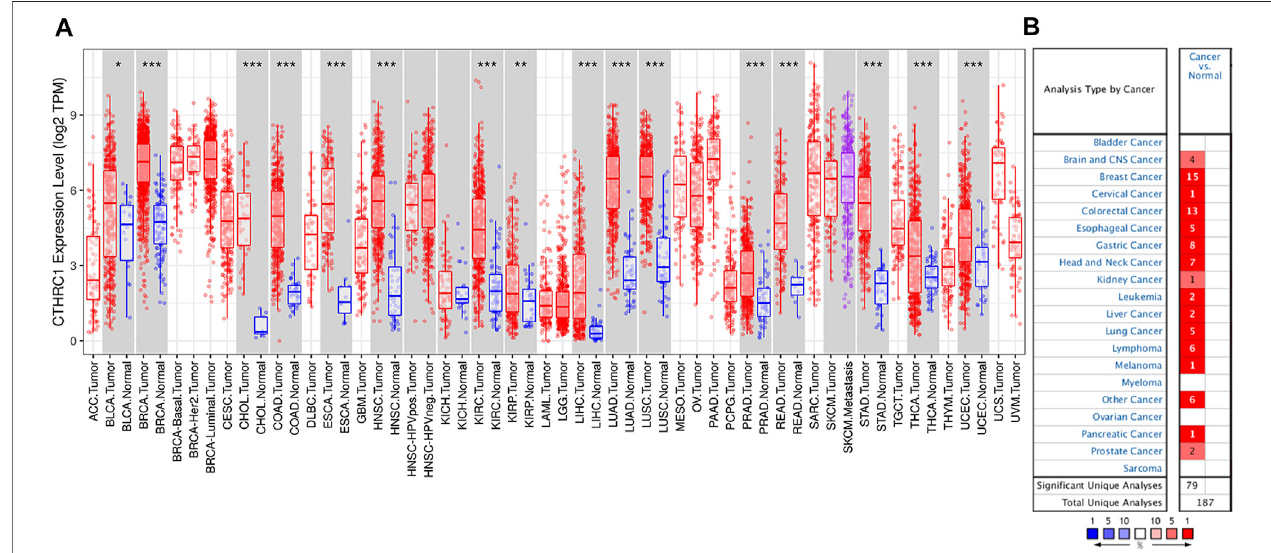
FIGURE 1 | Expression levels of CTHRC1 in different types of tumour tissues. (A) CTHRC1 expression in various tumour tissues via TIMER analysis. (B) CTHRC1 expression in different cancer types via Oncomine analysis (* p < 0.05; ** p < 0.01; *** p <